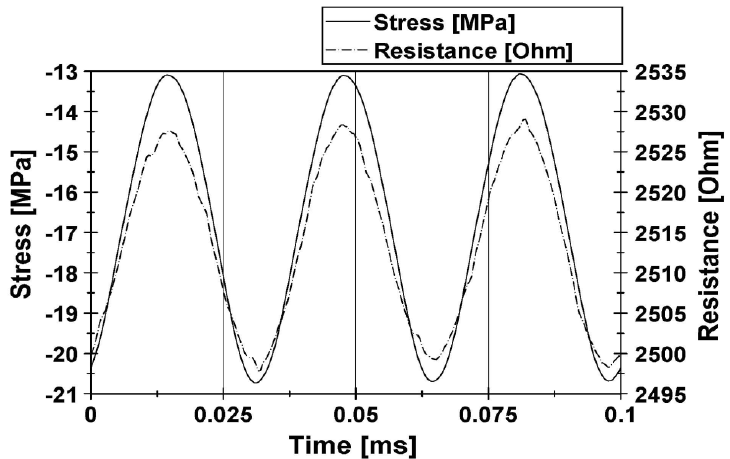
Figure 18. Piezoresistive response in silicon oxycarbide shown as the change of the electrical resistance upon applying a mechanical loading on the sample (reprinted with permission from Wiley)